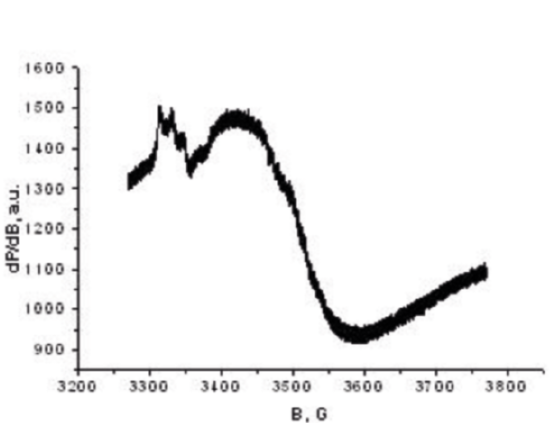
Figure 3. Mössbauer spectrum of sample “Precursor”. Figure 4. . EPR X-band spectrum of sample